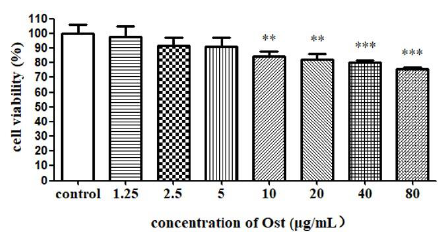
Figure 3. The cell viability of granulosa cells after treatment with Ost for 48 h. MTT was used to determine the cell viability. Data were expressed as Mean ± SEM. ** p < 0.01, *** p < 0.001.